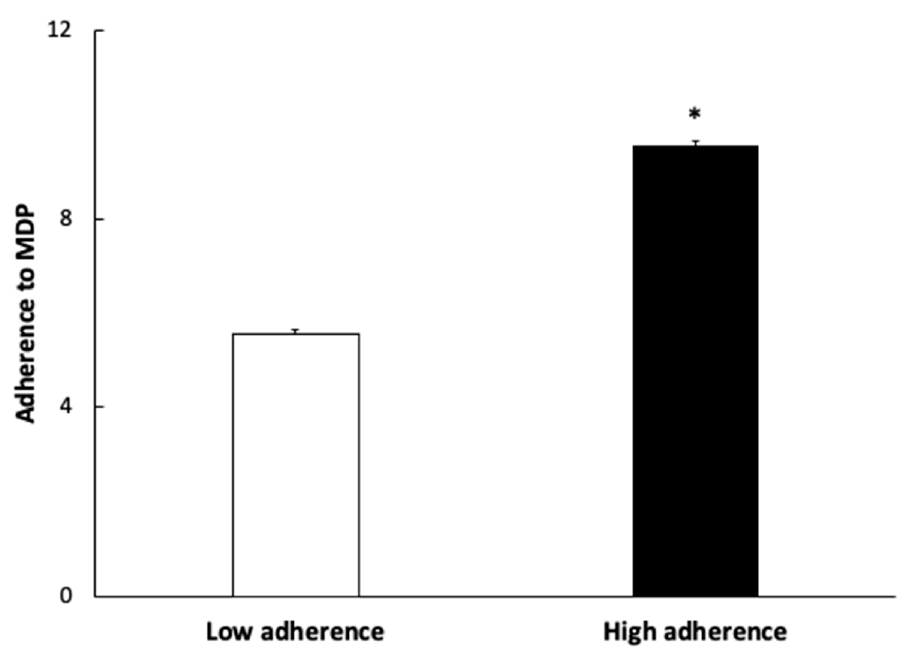
Figure 1. Adherence to Mediterranean Dietary Pattern (MDP) expressed as points obtained in the questionnaire. Results are presented as mean ± SEM. Data points in bold (*) are significant ( p < 0.05) by Student t -test. Table 1. Characteristics of participants according to adherence to median values of adherence to the Mediterranean diet